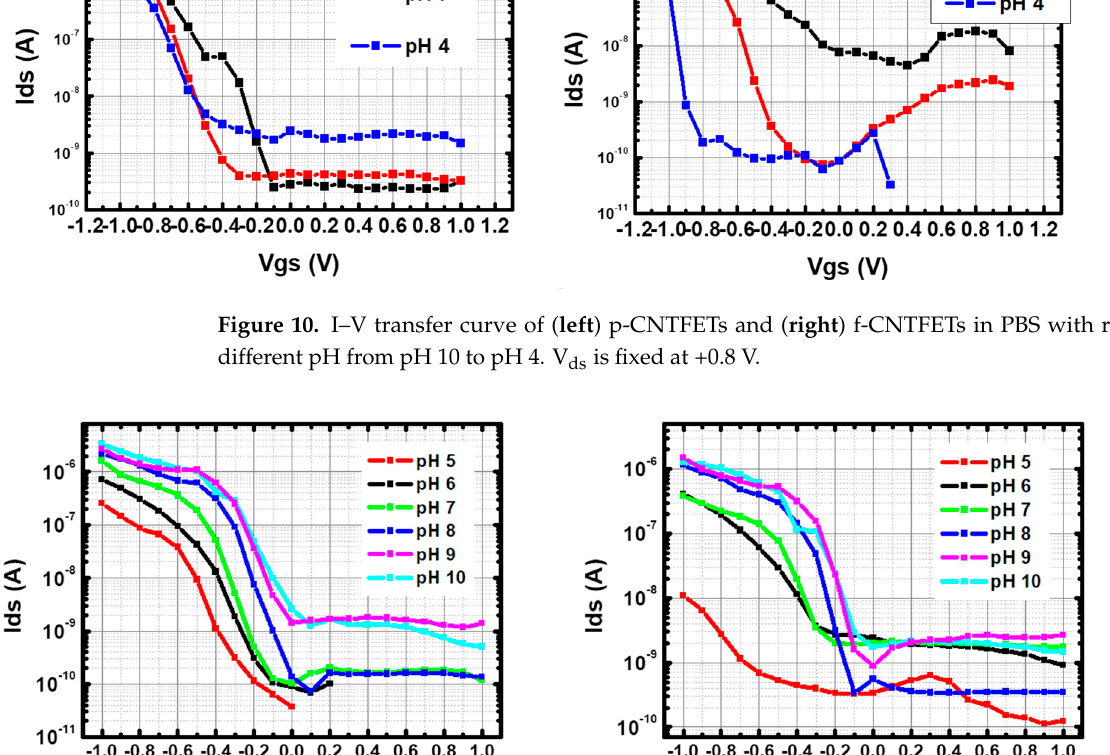
Figure 11. I–V transfer curve of ( left ) p-CNTFETs and ( right ) f-CNTFETs in BBS with respect to